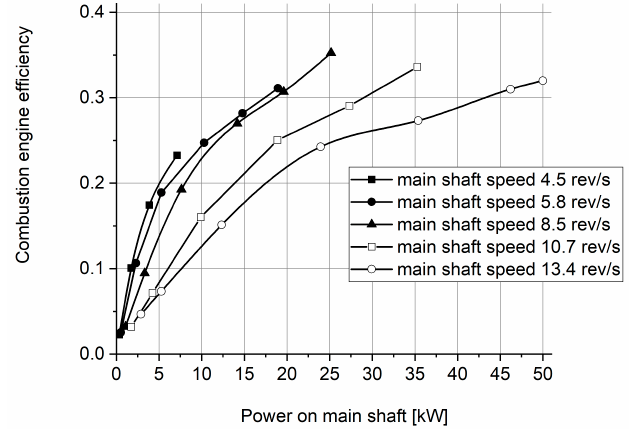
Figure 5. Measured efficiency in the internal combustion engine operation mode with a dedicated reduction gear as a function of the load and rotational speed of the main shaft.